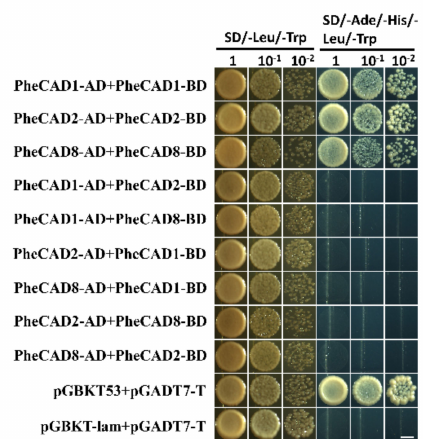
Figure 6. PheCAD1 , PheCAD2 and PheCAD8 enzyme homo-dimers were detected with Y2H experi- ments. All the combinations of PheCAD1 , PheCAD2 and PheCAD8 enzymes were used as both prey and bait. Yeast carrying pGBKT53, pGADT7-T used as positive control and pGBKT-lam, pGADT7-T used as a negative control. The transformed yeast cells grew on growth (SD/-Trp/-His) and selective (SD/-Ade/-His/-Trp/-His) media. Images were taken after 5 days of incubation at 30 ◦ C. Scale bar, 3